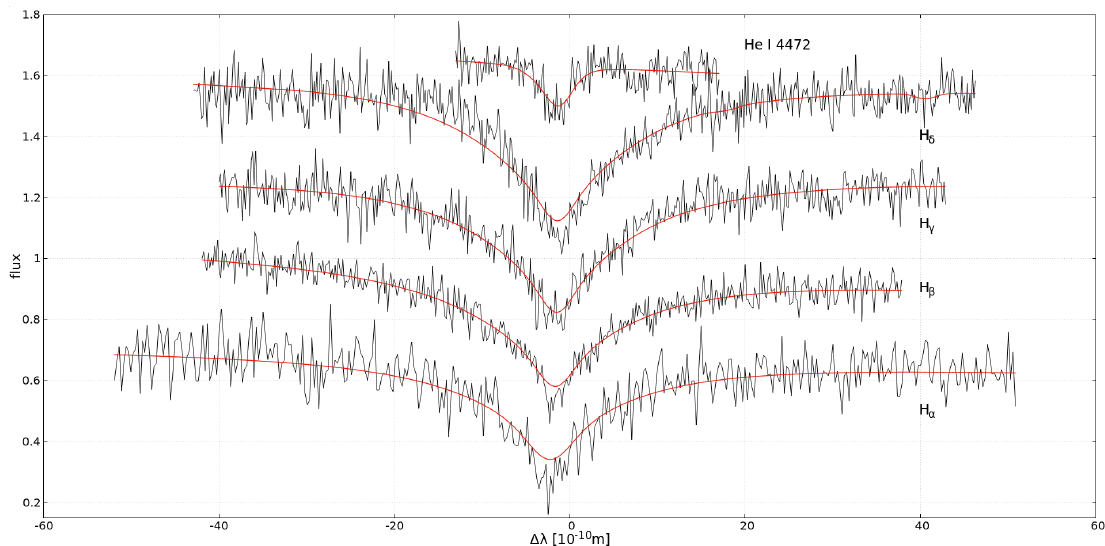
Figure 3. Example fit to several absorption lines of an individual Keck ESI spectrum to determine the atmospheric parameters. The synthetic spectra were calculated from LTE model atmospheres.